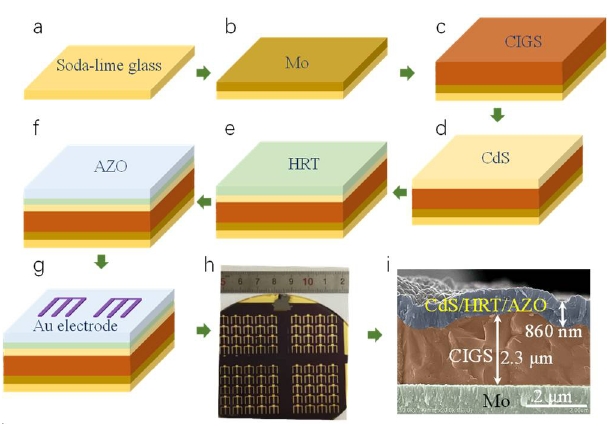
Figure 1. ( a – g ) Schematical illustration of the fabrication process for CIGS solar cells. ( h ) Photo images of actual CIGS solar cells. ( i ) Typical cross−sectional SEM image for a CIGS solar cell.